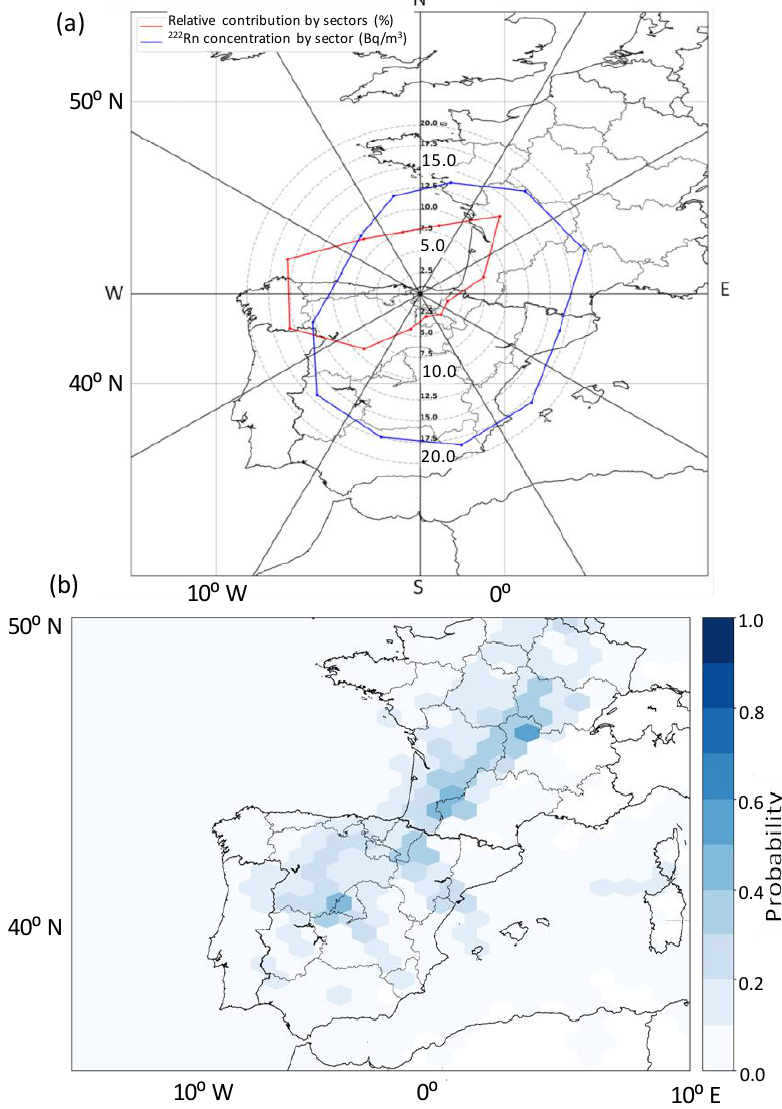
Figure 9. ( a ) Angular concentration and contribution profile for 222 Rn based on the TSA method, and ( b ) PSCF method identifying those areas more influencing the occurrence of the highest 222Rn activity concentrations at Bilbao.